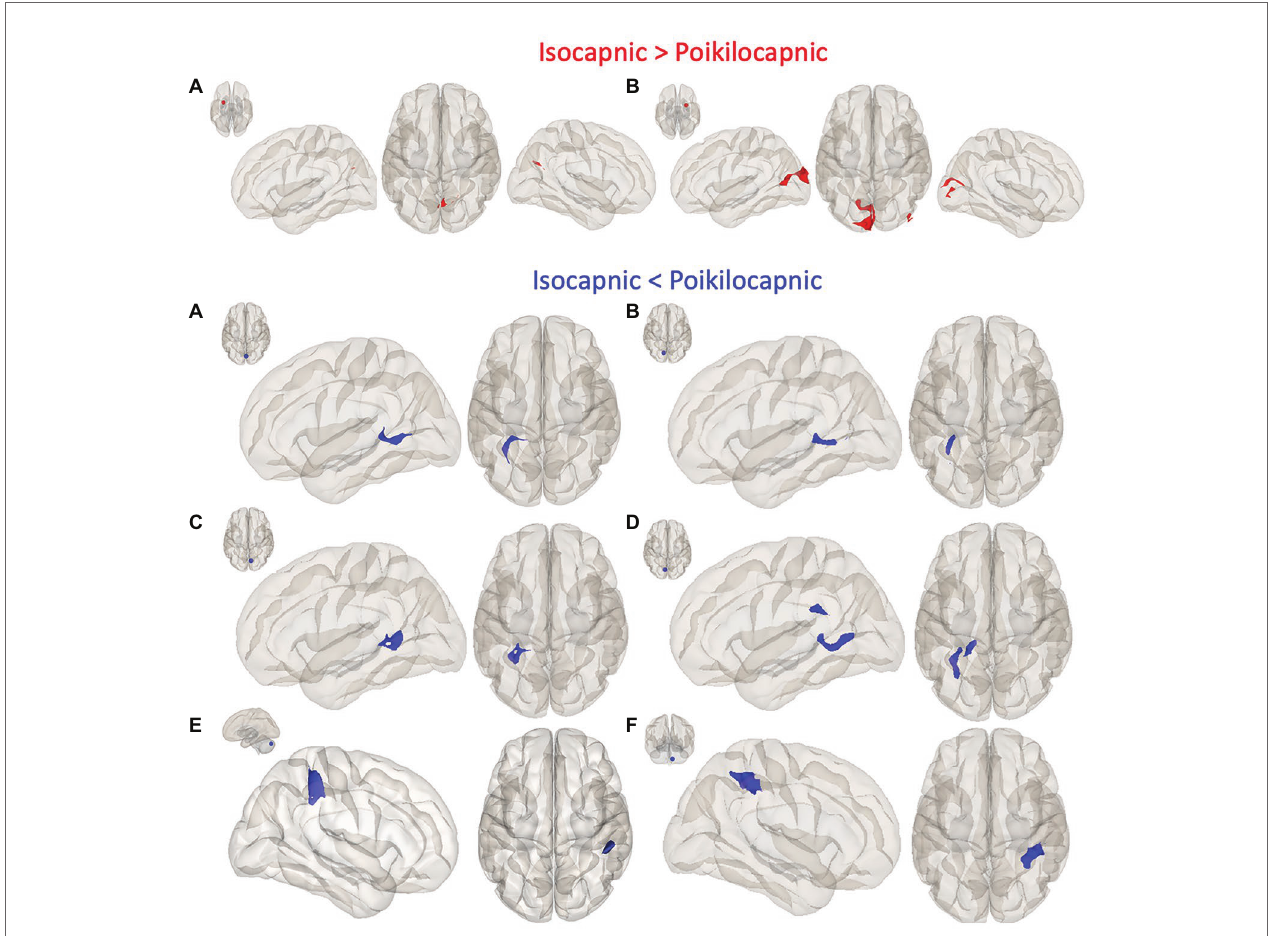
FIGURE 4 | Seed-to-voxel functional connectivity results. The first panel shows greater connectivity in the isocapnic condition (red) compared to the poikilocapnic condition; seed regions (red 10 mm ROIs) are depicted by the small axial brain images (top left), and red cluster regions shown in left sagittal, superior axial, and right sagittal views. (A) Left putamen seed, precuneus cortex cluster; (B) Right putamen seed, left occipital pole and right lateral occipital cortex clusters. Panels 2–4 show greater connectivity in the poikilocapnic condition (blue) compared to the isocapnic condition; seed regions (blue 10 mm ROIs), and blue cluster regions in the left sagittal and superior axial view. (A) primary visual network (PVN) seed, hippocampal formation cluster; (B) ICC seed, Hippocampus (Hi) cluster; (C) left SCC seed, Hi cluster; (D) right SCC seed, Hi/lingual gyrus cluster; (E) posterior cerebellar seed; supramarginal gyrus (SG) cluster; (F) Cerebellum region 9 seed; superior parietal lobule (SPL) cluster. Only significant family-wise error (FWE) corrected p < 0.05 are